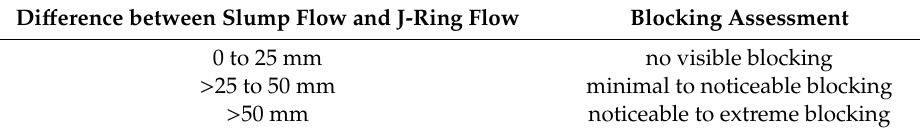
Table 3. J-Ring test blocking assessment.